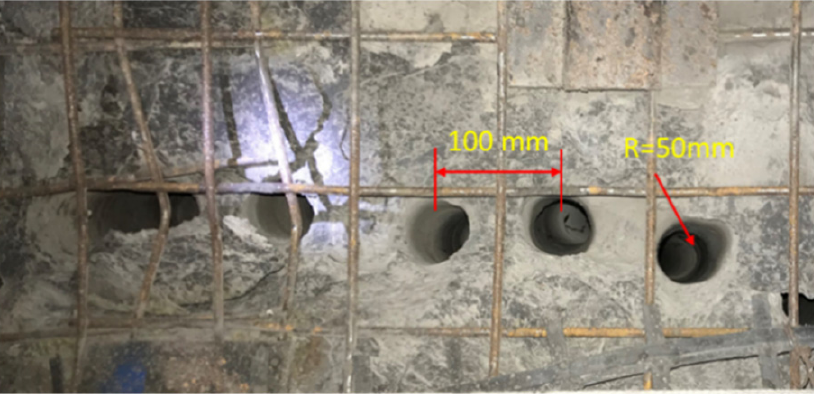
Figure 12. Field layout of the dense pressure-released holes.